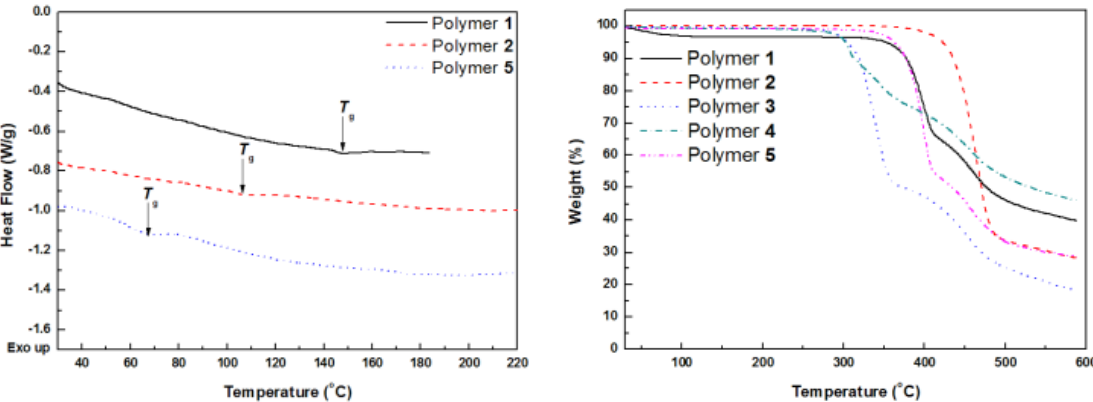
Figure 7. ( Left ) differential scanning calorimetry (DSC) thermograms of the polymers 1 , 2 , and 5 and ( Right ) TGA thermograms of the polymers 1 − 5 obtained at a heating rate of 10 °C/min in nitrogen.